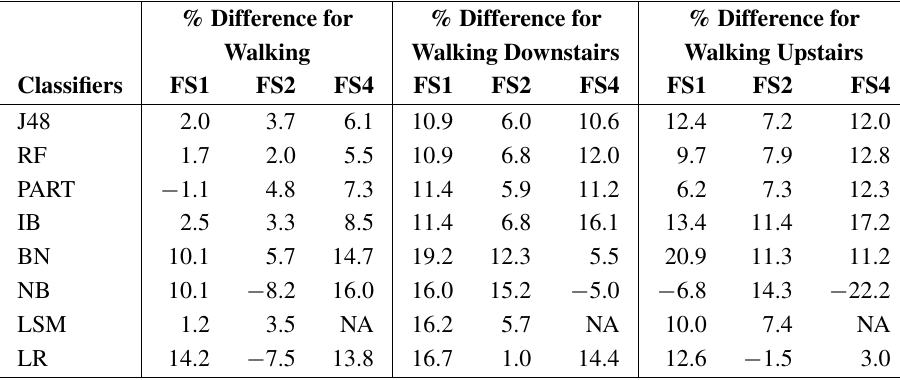
Table A.8. Performance difference (AG—max(A,G)) for the walking, walking downstairs and walking upstairs activities in Scenario B.